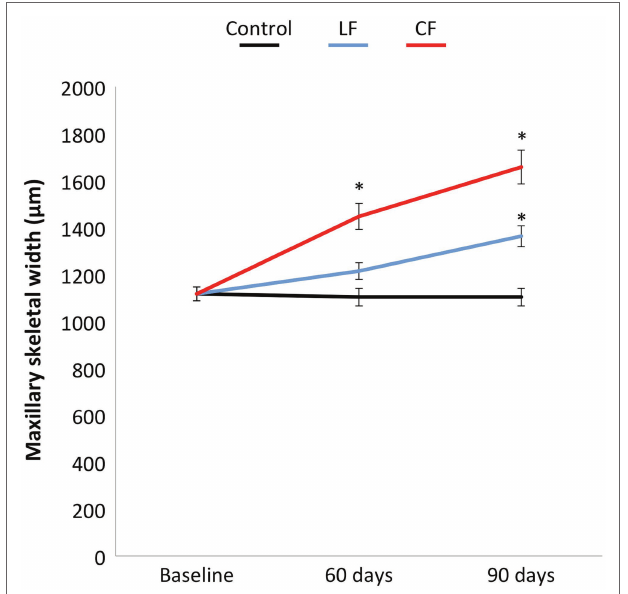
FIGURE 2 | The low or conventional transpalatal continuous force created in addition to tooth movement a constant increase in maxillary skeletal width in both force groups. A larger opening of the midpalatal suture was found for the conventional force. The skeletal width in the control group remained